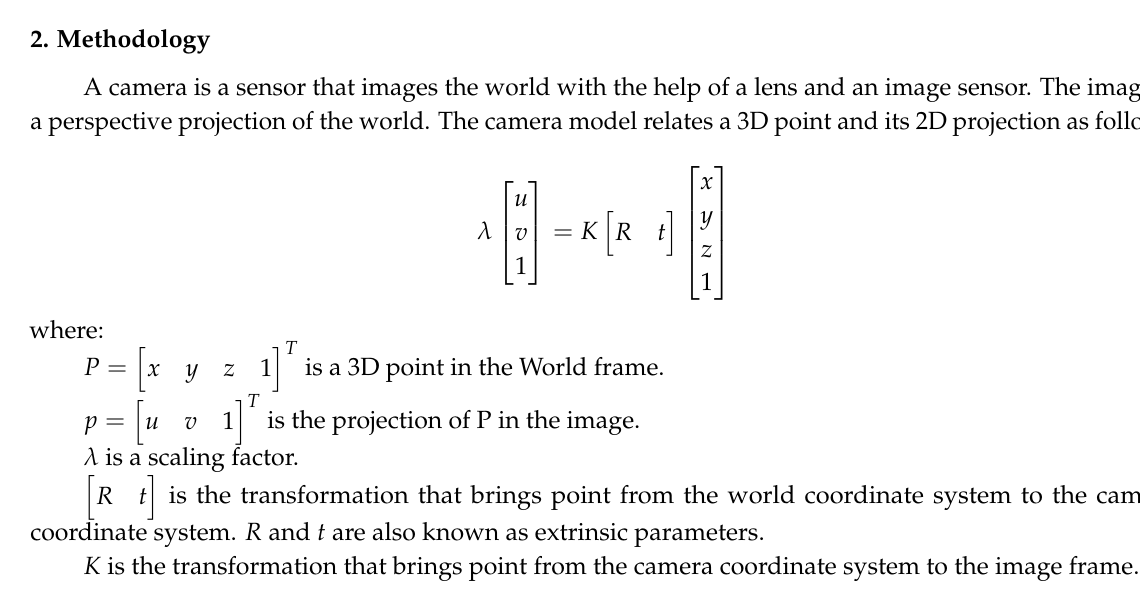
Figure 1. Camera views used for extrinsic